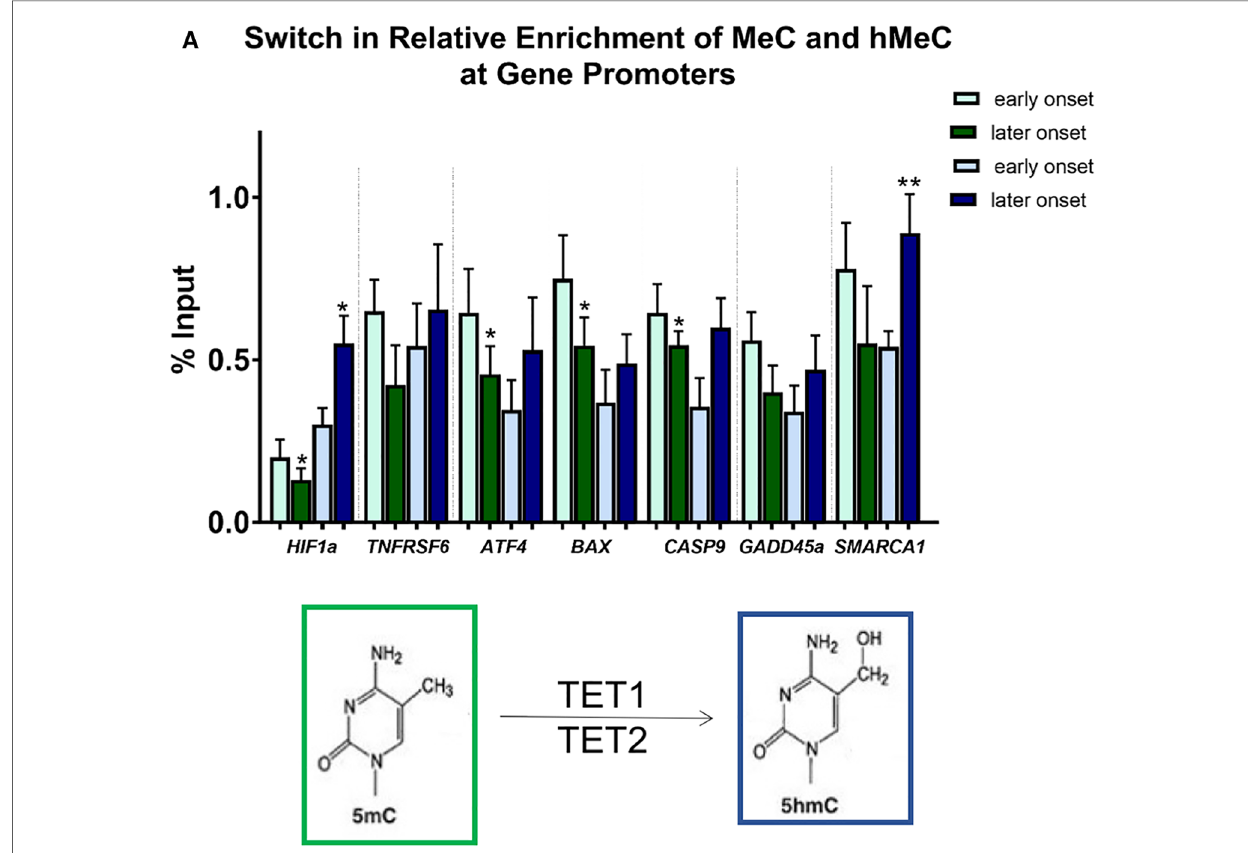
FIGURE 7 Differential methylation and demethylation is associated with changes in expression patterns of genes responsible for epigenetic regulation. ( A ) Chromatin immunoprecipitation analysis revealed a loss of DNA methylation and an increase in hydroxymethylation at promotors of selected differentially expressed genes in later vs. earlier onset toxic cardiomyopathy. * p <0.05, ** p